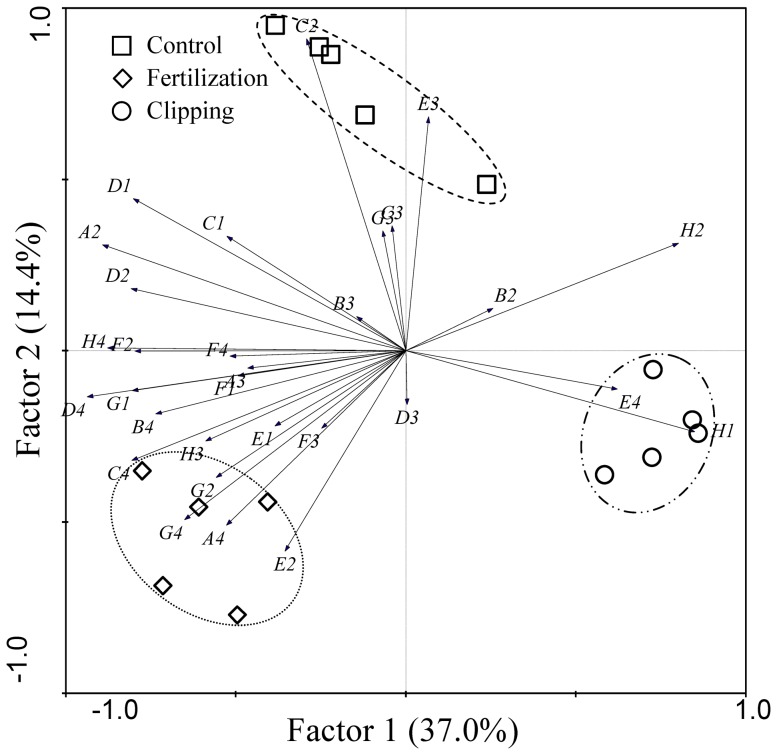
Principle components analysis of biological data in July, 2012 (72 h).